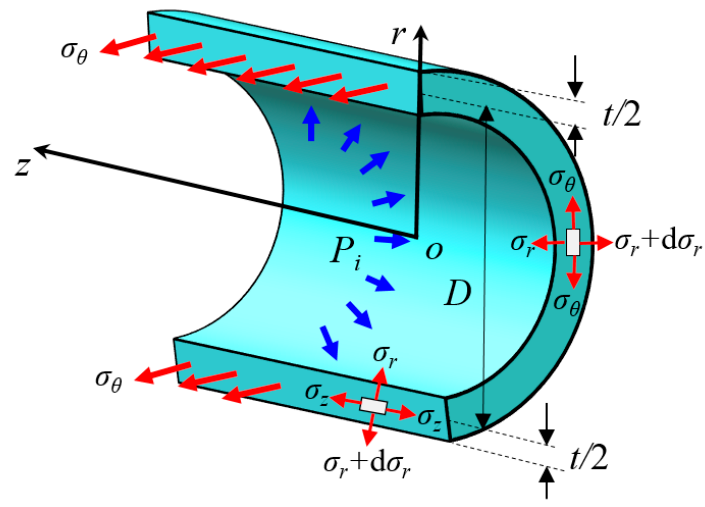
Figure 6. The force and deformation of the cylindrical unit under internal pressure.